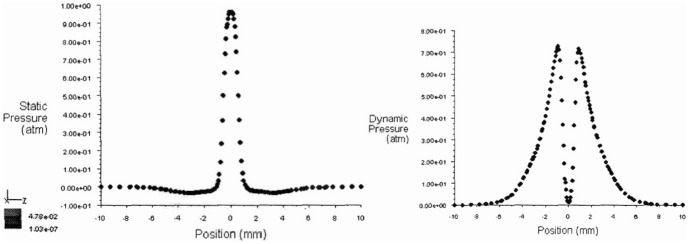
Contour of static and dynamic pressure distribution of Y axis.